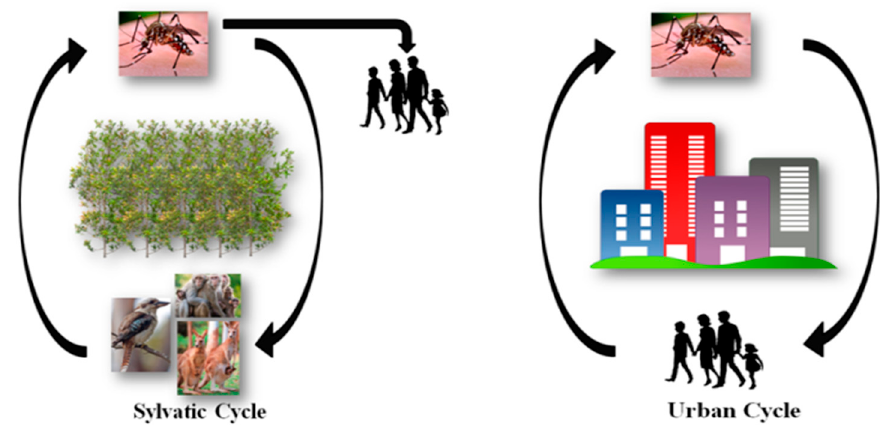
Figure 1. Alphaviral transmission: the sylvatic and urban cycles.